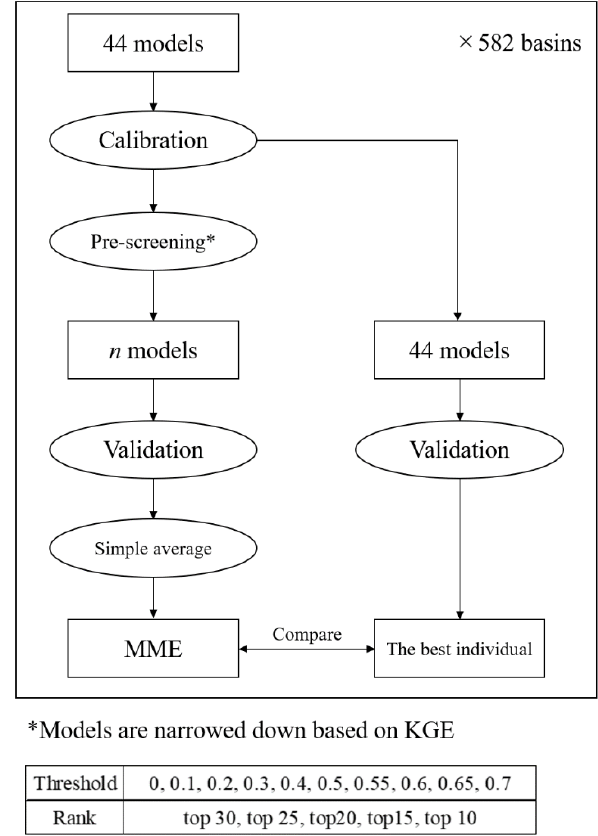
Figure 2. Flowchart of MME evaluation.